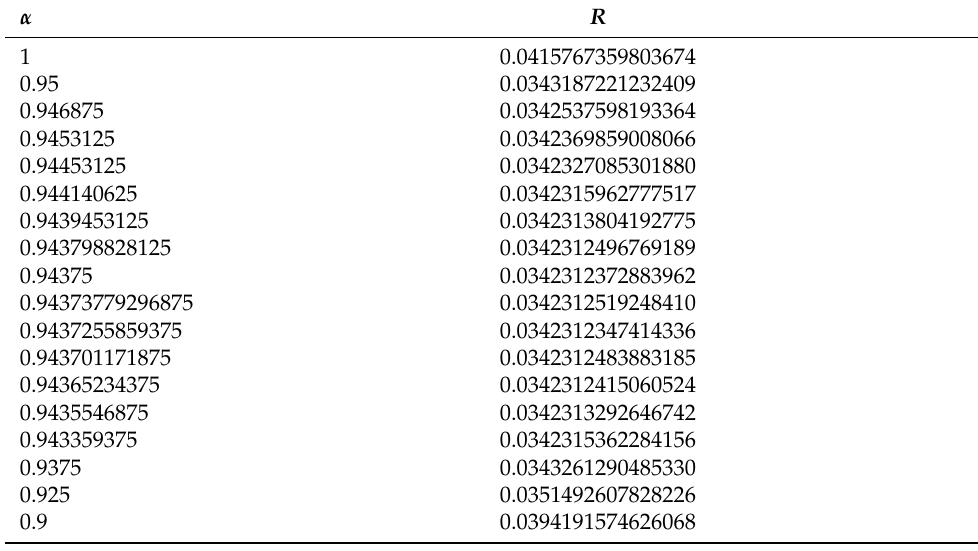
Table 1. Residual norm for different α .